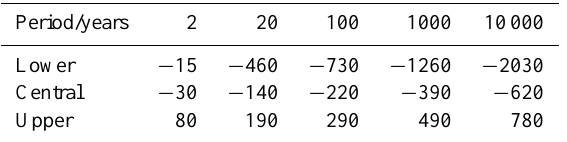
Table 5. Projected century-scale trends in significant wave height for five return periods due to storminess changes (mm per century, to two decimal places).